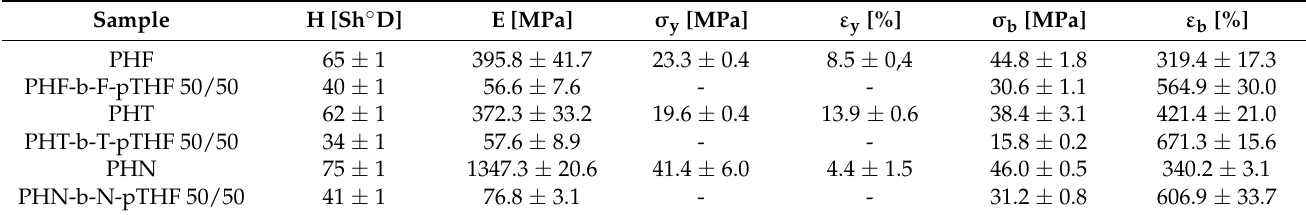
Table 7. Tensile properties of synthesized polyesters and